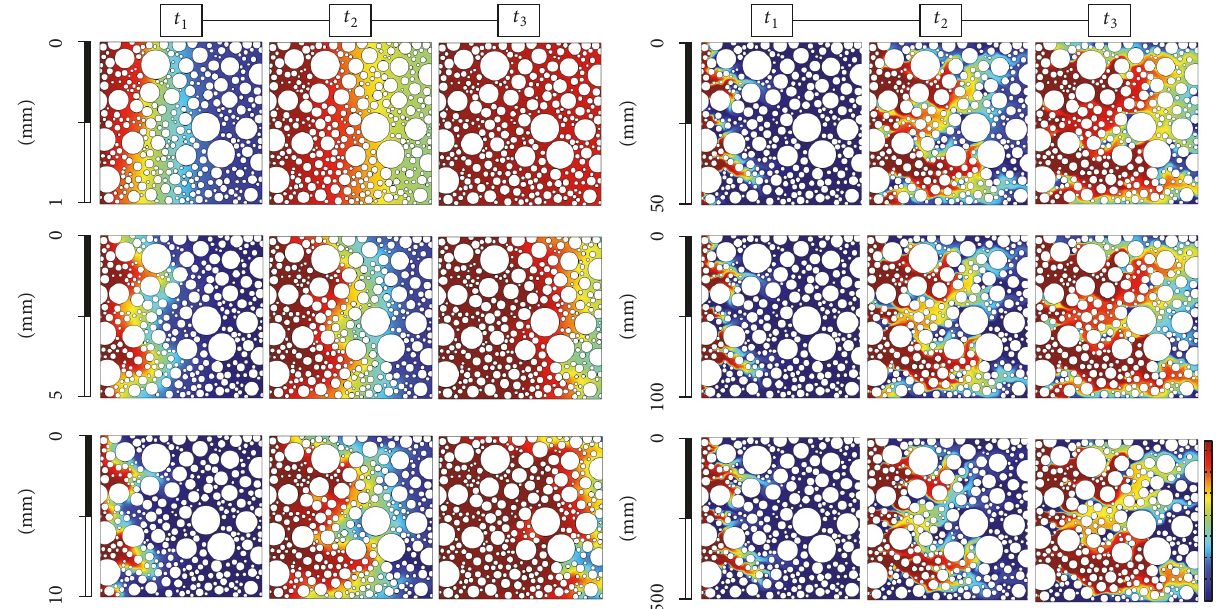
Figure 8: Relative Concentration (RC) of the mass (tracer) for the model with the length scale of 1, 5, 10, 50, 100, and 500 mm.